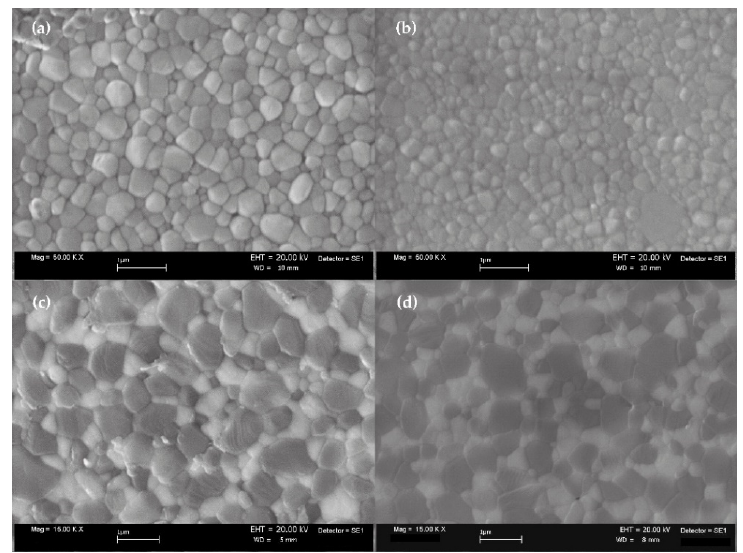
Figure 3. SEM micrographs of zirconia samples 3Y-TZP SSS ( a ) and 3Y-TZP TSS ( b ), as well as of ZTA samples 60403Y SSS ( c ) and 60403Y TSS ( d ).